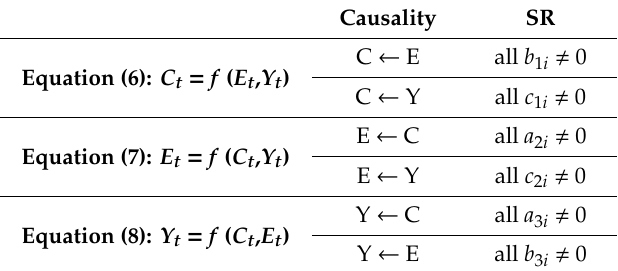
Table 1. Causality in vector auto-regressive (VAR)